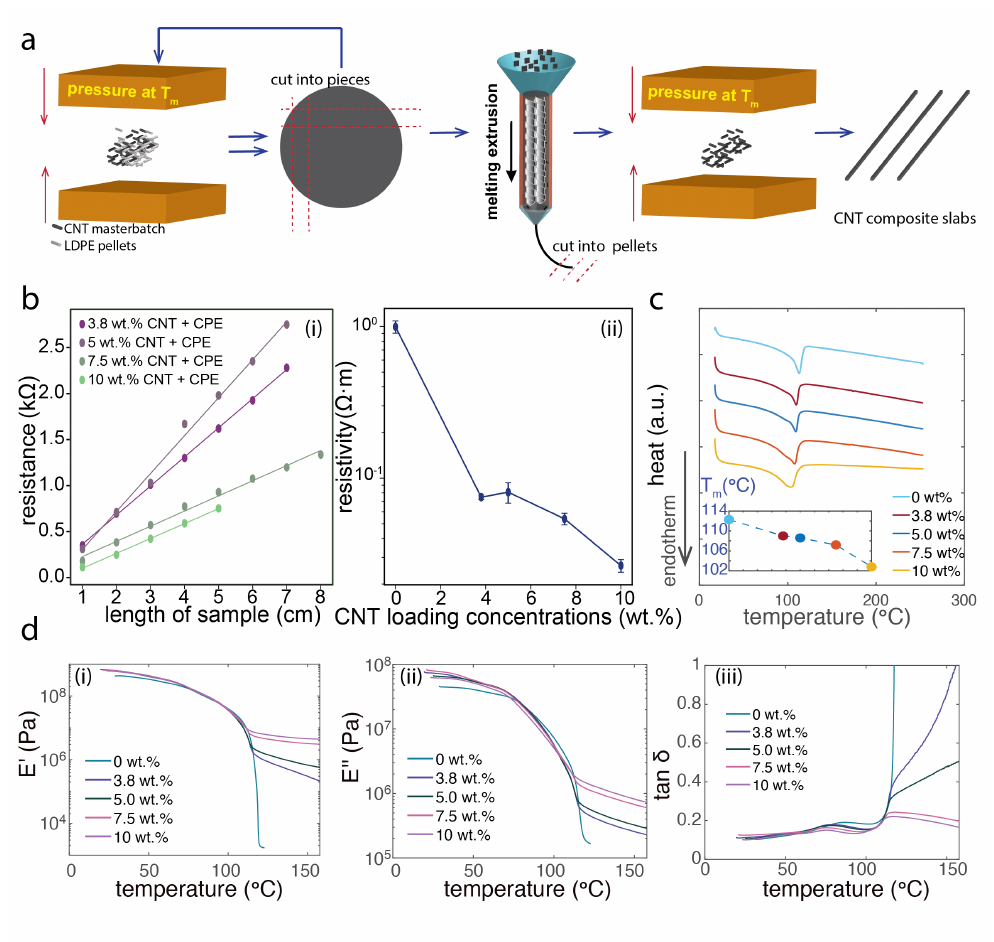
Figure 1. The composite synthesis with hybrid fillers (carbon nanotubes (CNTs) and carbon blacks (CBs)) and their detailed electrical, thermal and thermomechanical characterizations. ( a ) A schematic of synthesis process of the polymer composite with CNTs and CBs. ( b ) The electrical characterization of the bulk polymer composite showing homogeneous dispersion in ( i ) and the resistivity with a higher loading of CNTs. ( c ) Thermal analysis of crystallization and melting behavior of the composites. ( d ) Dynamic mechanical properties of the